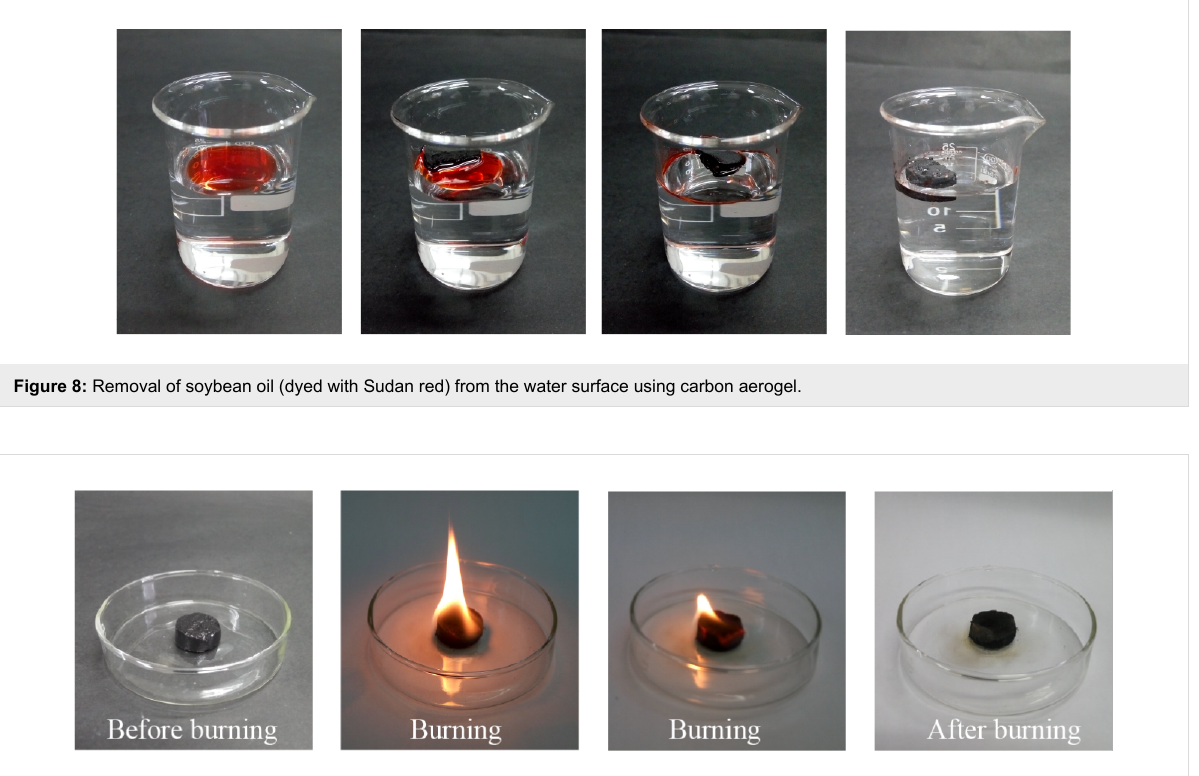
Figure 7: Contact angle of CNF/PVA/GO carbon aerogels.